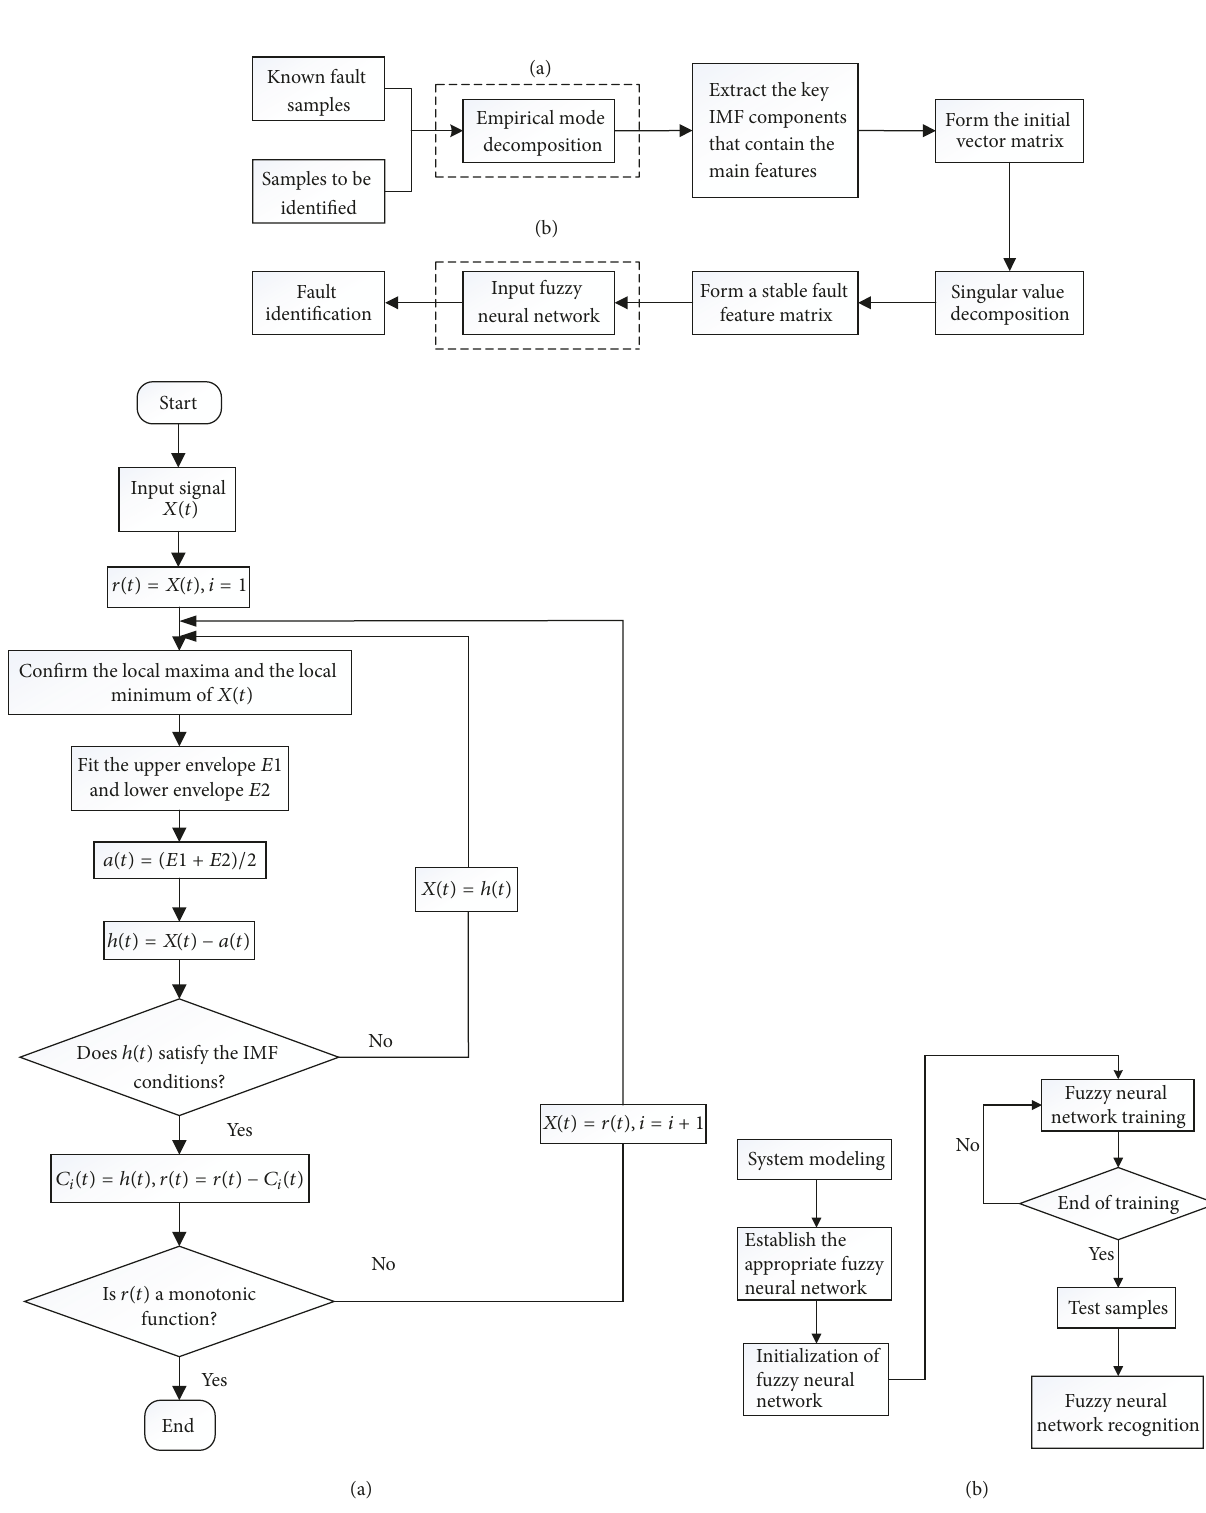
Figure 2: Fault diagnosis method based on EMD-SVD and fuzzy neural